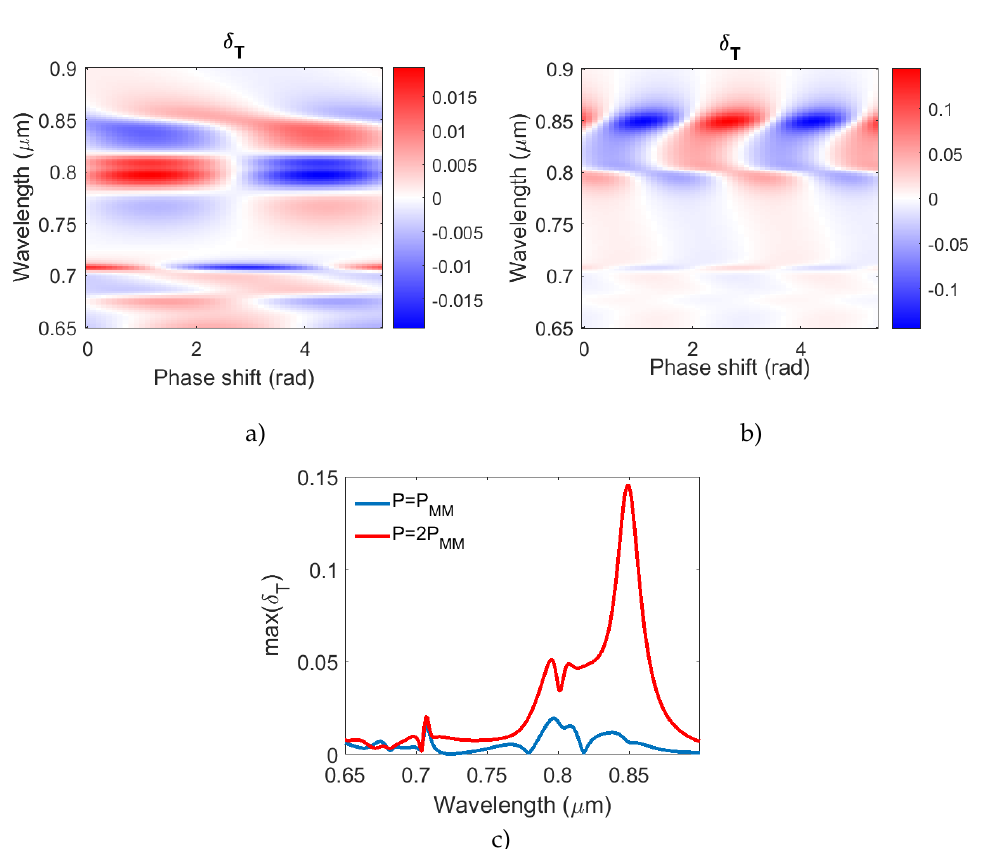
Figure 5. The magneto-optical effect δ T versus the phase shift φ between the plasmonic grating and the spin wave for two periods of the magnetization modulation. ( a ) The magnetization modulation period is equal to the period of the plasmonic grating. ( b ) The magnetization modulation period is equal to the half of the period of the plasmonic grating. ( c ) The spectral dependence of the maximum value of δ T for two different periods of magnetization